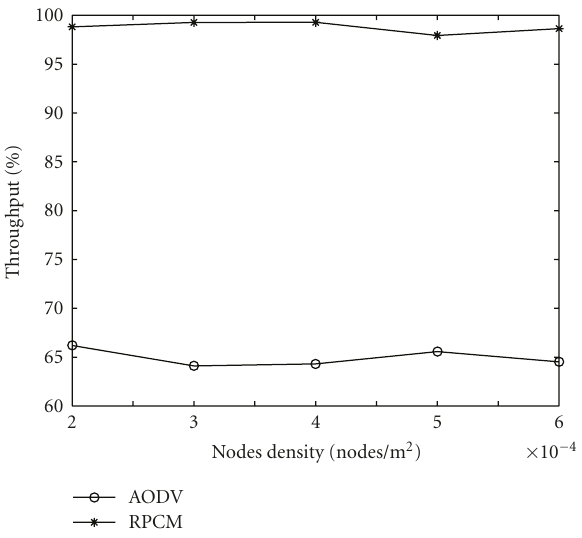
Figure 8: Performance of AODV and RPCM in terms of energy spent for received packet, when f = 6.